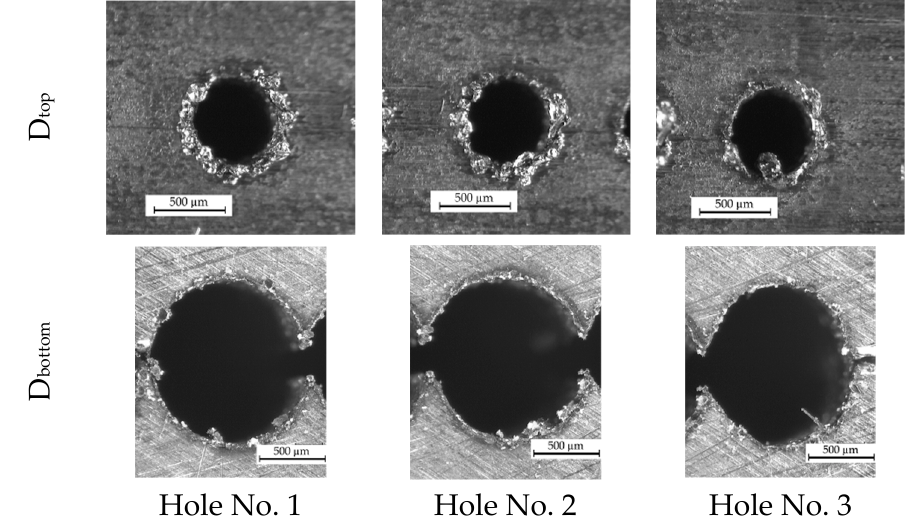
Figure 10. Through holes drilled with the application of the same machining parameters: t i = 282 µs, U = 120 V, I = 4.32 A.